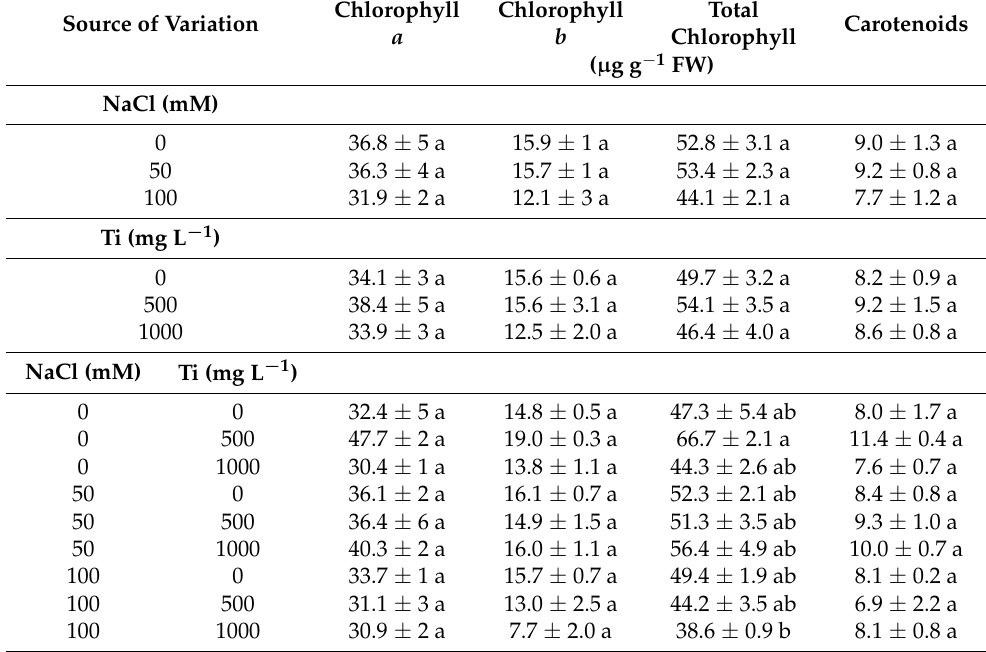
Table 3. Main and interaction effects of NaCl and TiO 2 on photosynthetic pigments in leaves of tomato ( Solanum lycopersicum L.) seedlings cv. Rio Grande.